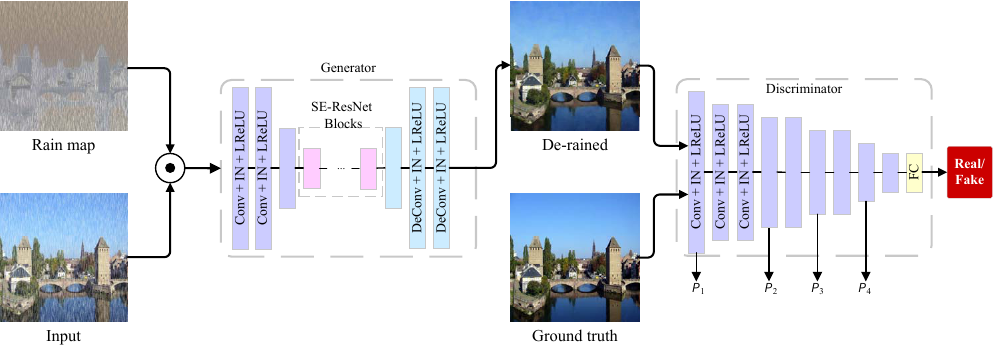
Figure 4. The architecture of proposed GAN model. The generator consists of stride convolution layers, residual blocks and stride de-convolution layers. The discriminator is a binary classification based on CNNs. Reproduced with permission from Li et al. [13], published by 2019 IEEE International Conference on Multimedia and Expo (ICME).